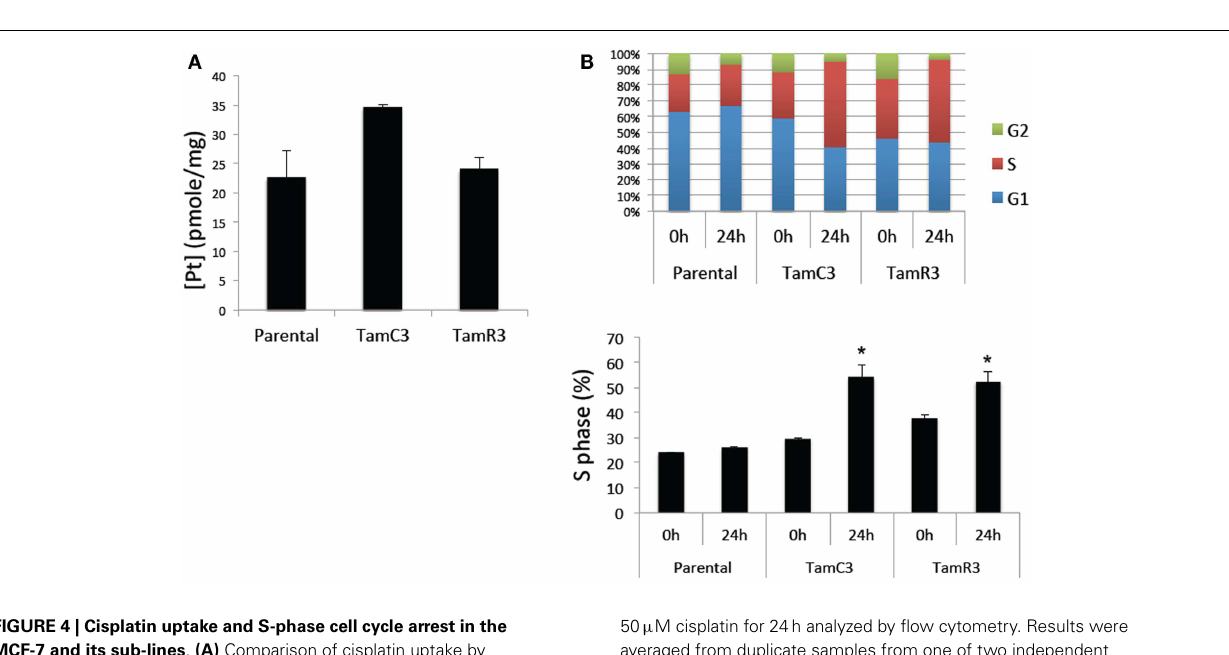
50 µ M cisplatin for 24h analyzed by flow cytometry. Results were averaged from duplicate samples from one of two independent experiments. *Significant difference from treatment control ( p <